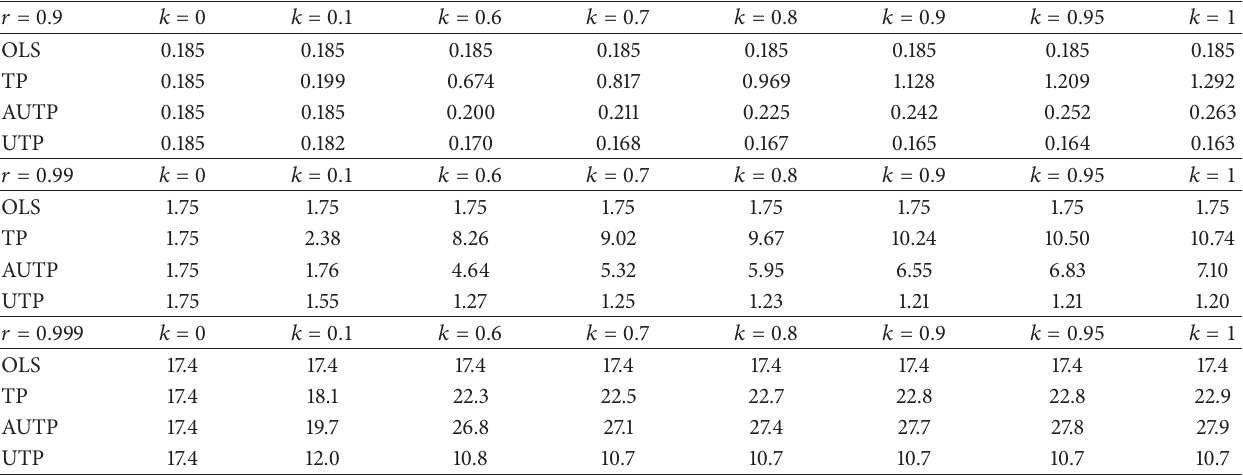
Table 5: Estimated MSE values of OLS, TP, AUTP, and UTP when 𝑛 = 25 , 𝑝 = 6 , and 𝜎 2 = 0.1 .